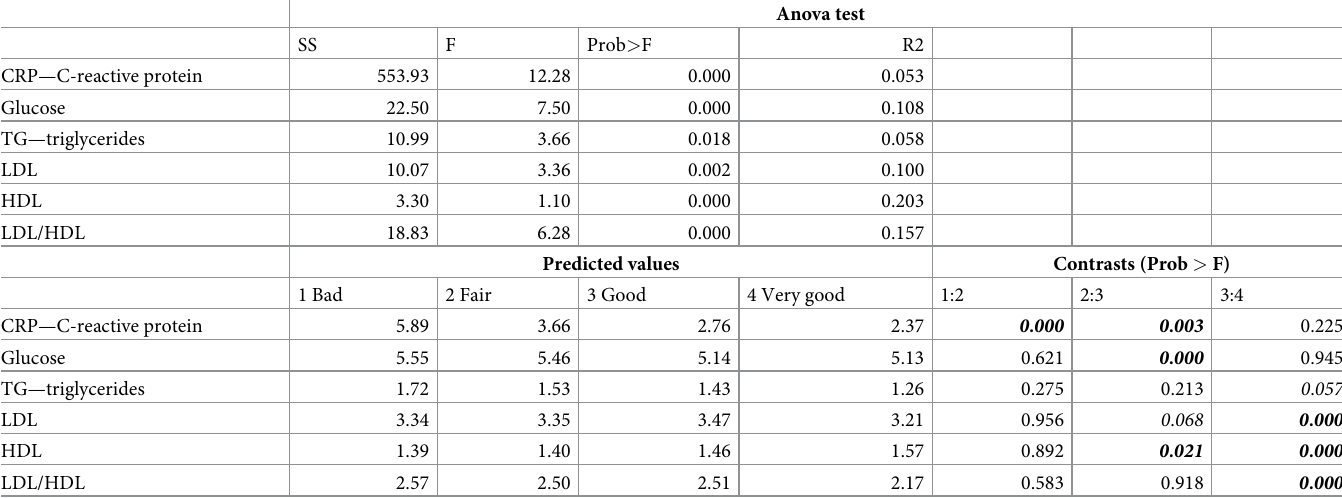
Table 3. ANOVA test for biomarker differences by SRH category, predicted values, and contrasts between